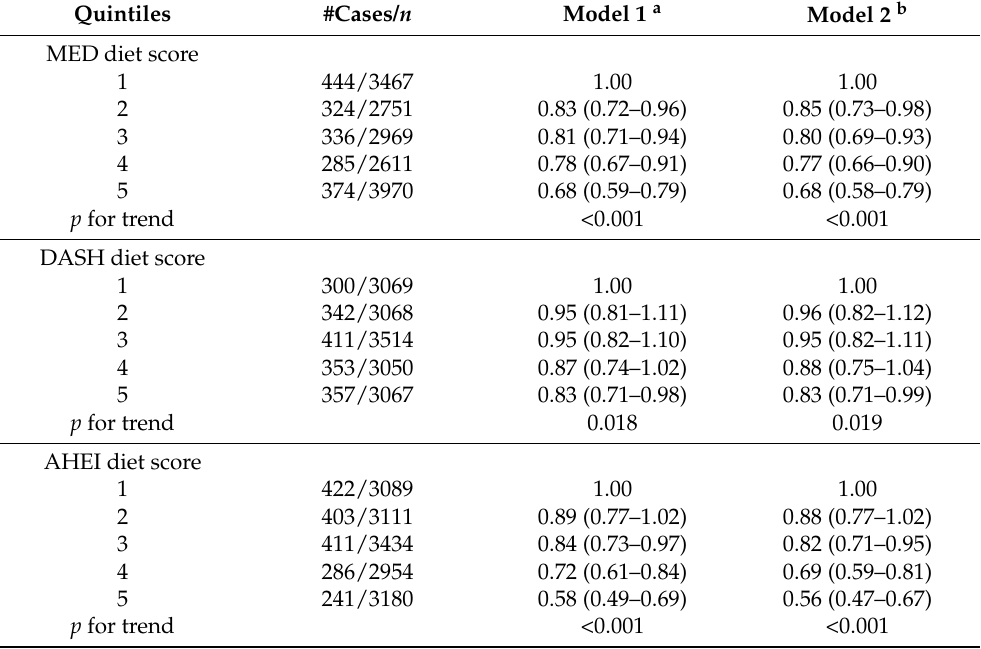
Table 2. HR (95% CIs) for all-cause mortality according to quintiles of MED, DASH, and AHEI scores among 15,768 men in the Physicians’ Health